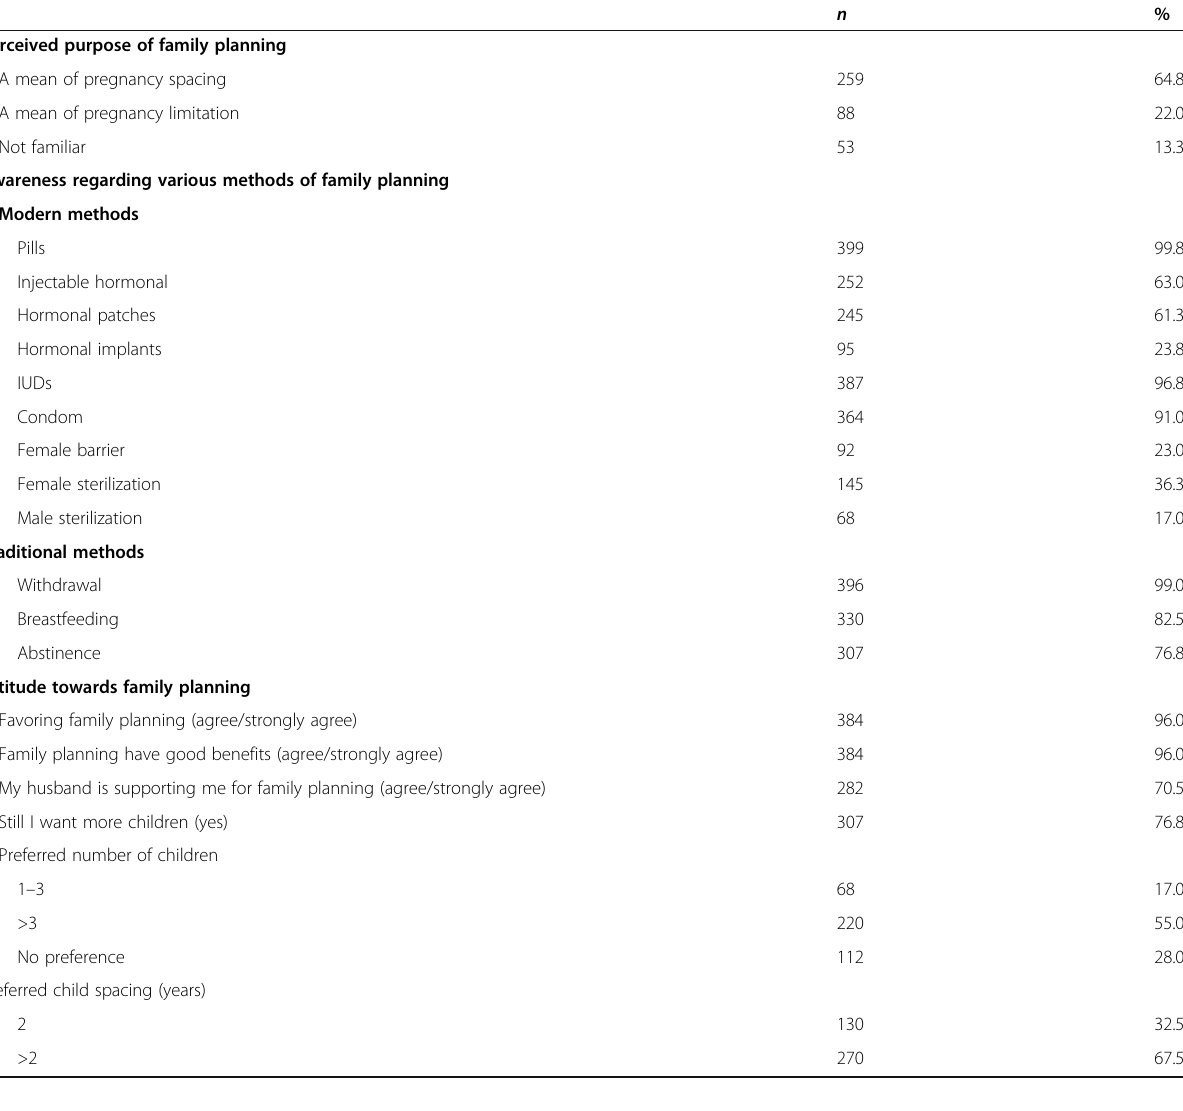
Table 2 Awareness about and attitude towards family planning